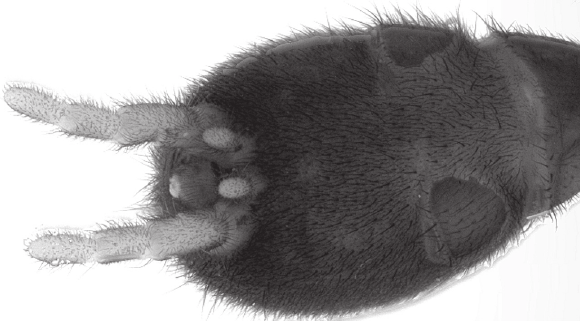
Figure 1. Fufius striatipes comb. nov. , holotype male. Ventral as- pect of abdomen, showing